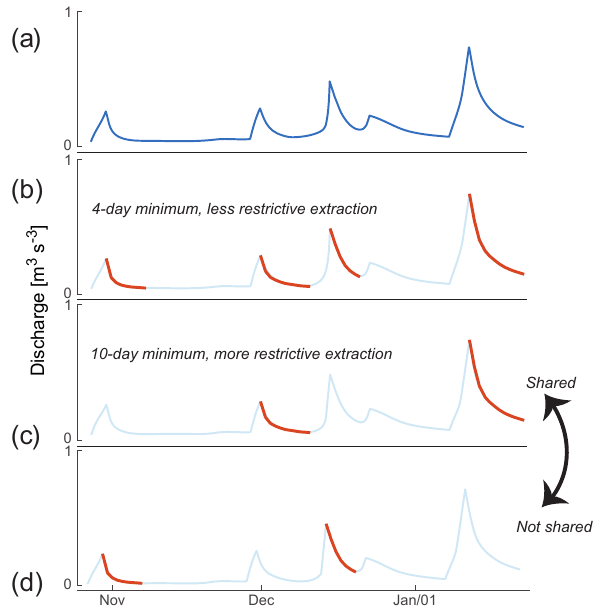
Figure 5. Example recession extraction from the hydrograph (a) using a less restrictive method M = 0 (b) and a more restrictive method M = 1 (c) . The recessions identified by the more restrictive method will be “shared” by the two methods, in the sense that they will by definition also be identified by the less restrictive method. Recessions identified by only the less restrictive method (d) are classified as